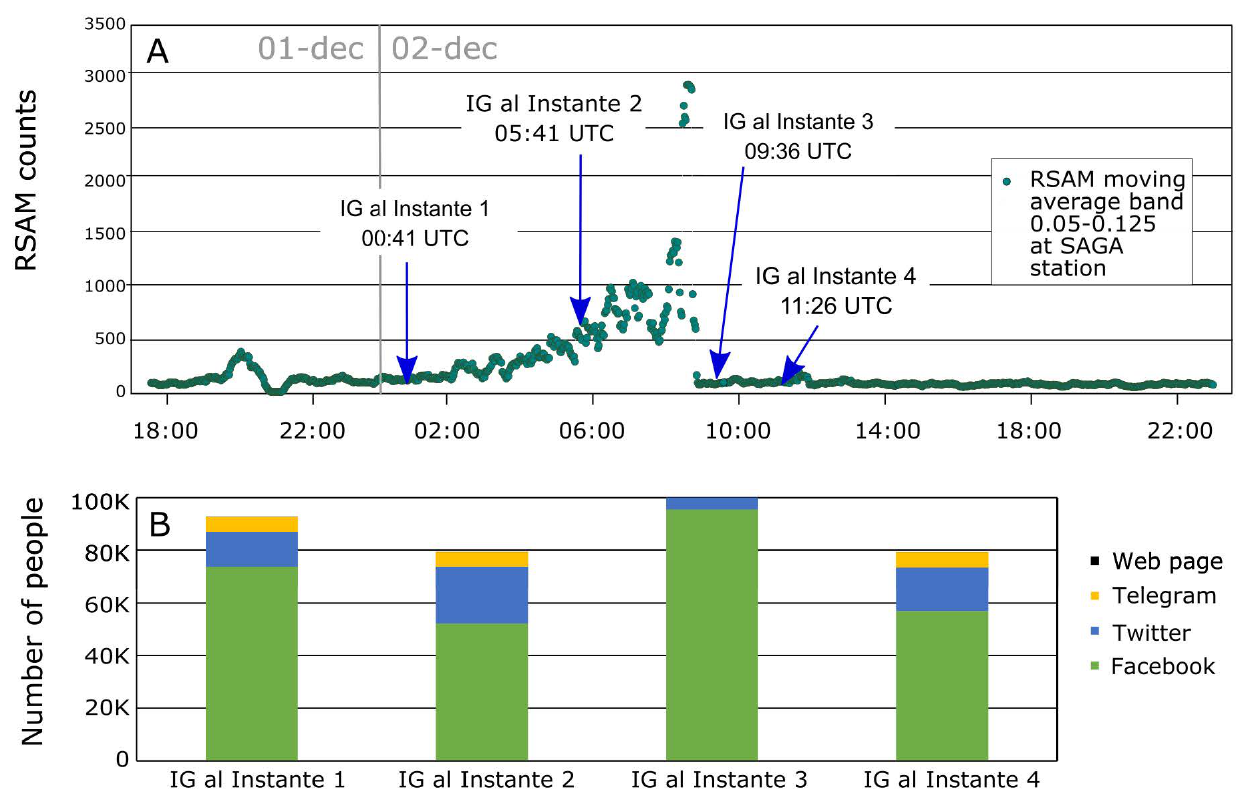
Figure 13: [A] RSAM moving average combined with the communication of eruptive process showing the time of publication for IGalInstante reports and their reach out in our social media channels, [B] Bar chart of the number of people reached by the IGalInstante